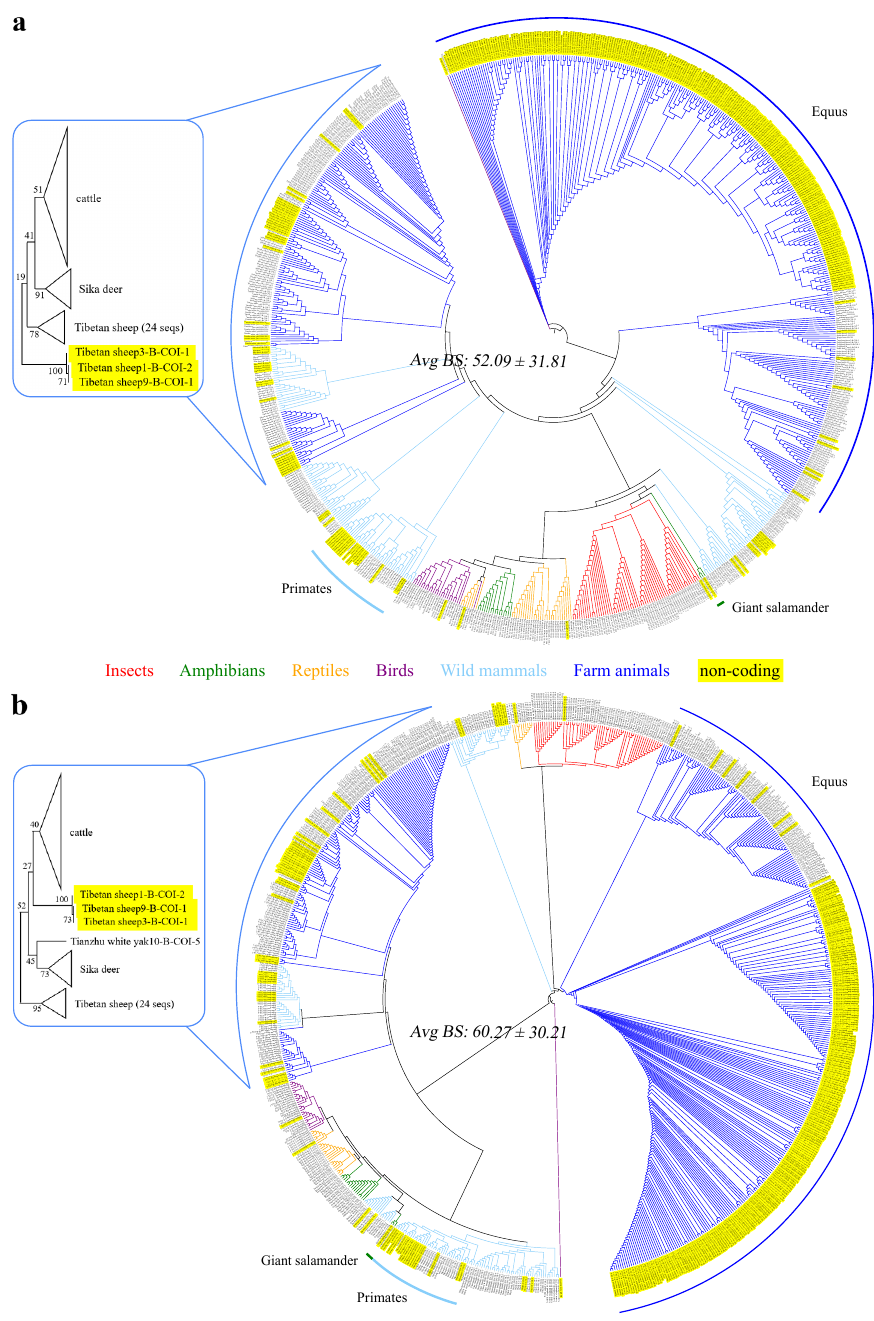
Figure 6. NJ (a) and ML (b) trees inferred from COI haplotypes using K2P distances. Highlighted boxes show a more detailed view of Sika deer, Tibetan sheep and cattle with bootstrap values. Sequences from Giant salamander, primates and Equus (horse and donkey) are also highlighted. (Avg BS) average bootstrap